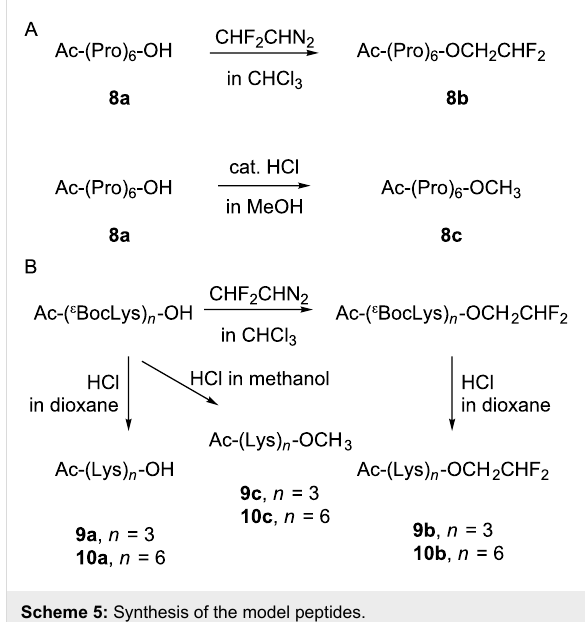
Scheme 5: Synthesis of the model peptides.